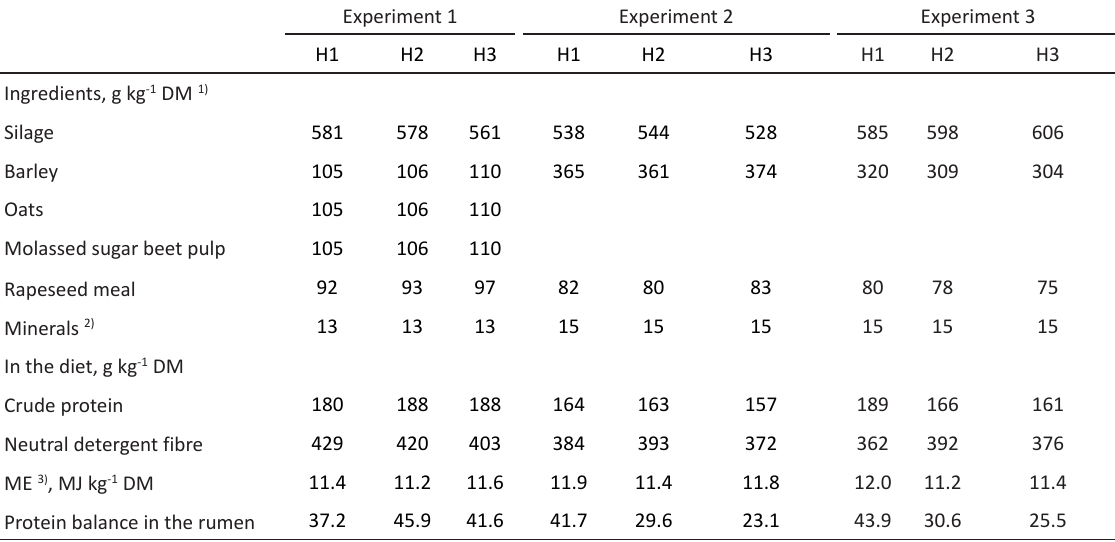
Table 1. The ingredients of diets (TMR in Experiments 2 and 3) and their nutritional composition for first (H1), second (H2) and third cut (H3) of grass